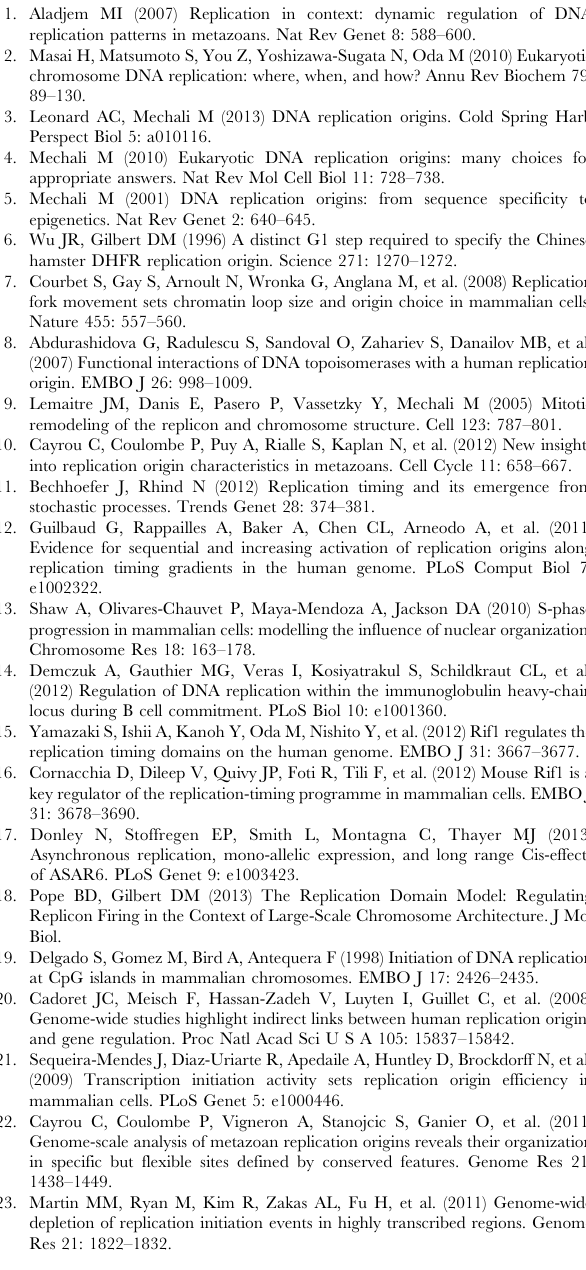
Table S3 List of imprinted genes and their timing asynchrony in erythroblasts. See text for definition of ARD, core ARD and method to calculate the delays. Some ARD exhibited several cores other did not have any detectable core with the parameter used in the island finder. Table S4 Coefficient of correlation between TimEX-seq and BrdU nascent strand profiles. S/G1 ratios smoothed at 20 kb and BrdU NS density were compared genome-wide. Both the S/G1 ratio and the BrdU NS were binned into 3 Kb windows. The S/ G1 ratio was smoothed using a 20 kb sigma. The BrdU NS were either unsmoothed or smoothed with a 20 kb sigma.